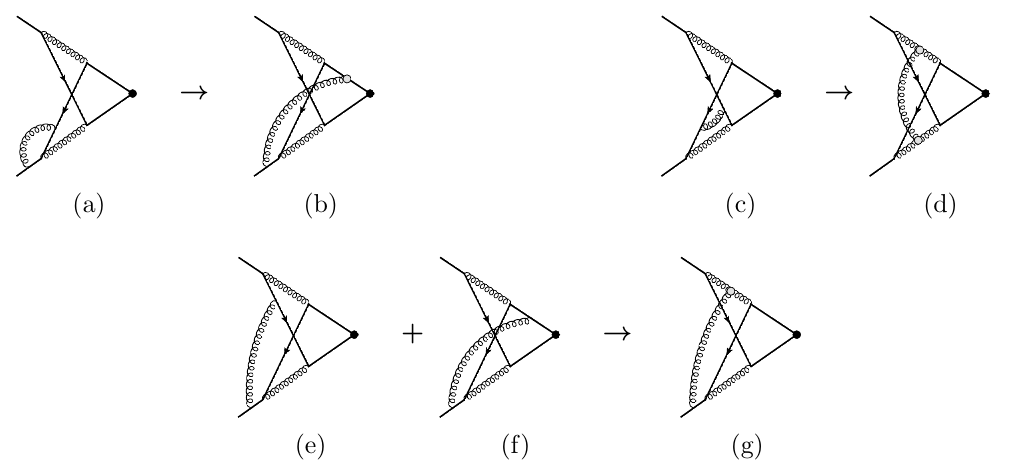
Figure 8 . Diagramatic representation of the transformation which moves the soft gauge boson vertex from a soft quark to an eikonal